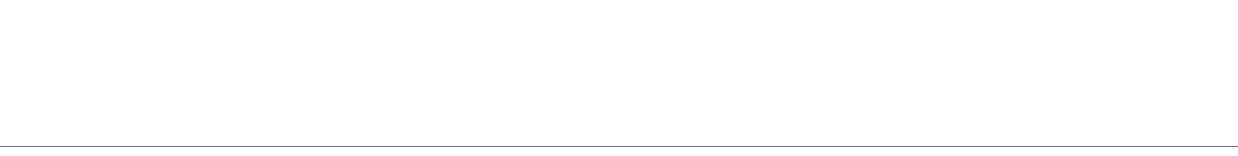
Frontiers in Molecular Biosciences |